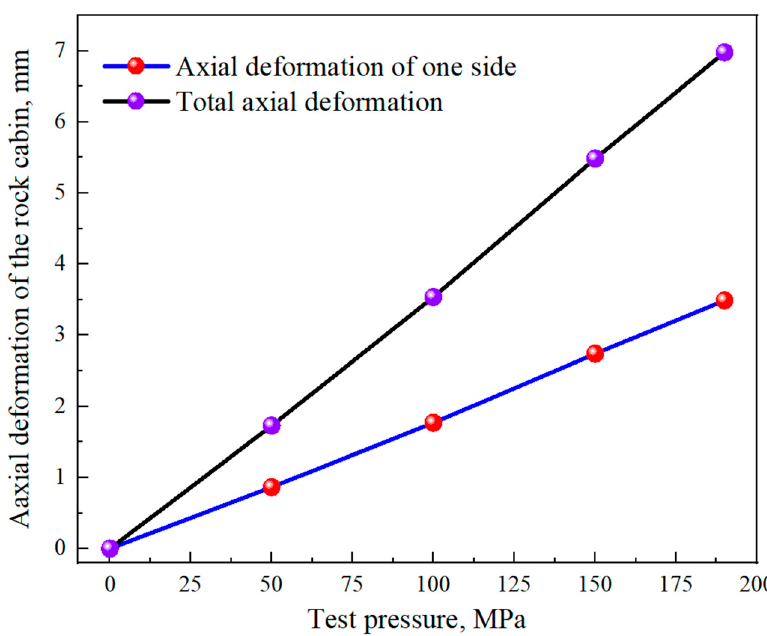
Figure 11. Axial deformation of the rock cabin.